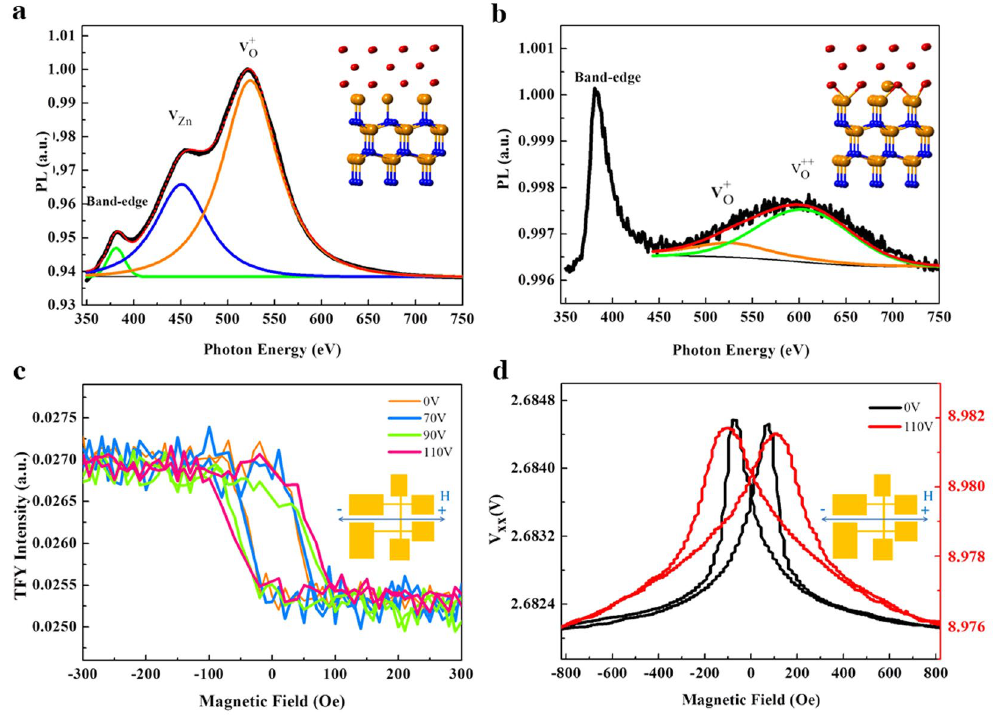
Figure 5. Magnetic properties with ex-situ treatment . PL spectra for the device ( a ) with and ( b ) without 110 V- ex-situ treatment . Inset figures of ( a ) and ( b ) illustrate the Fe-ZnO bond-broken and bond-formed situations for with and without 110 V- ex-situ treatment , respectively. ( c ) Voltage-dependent hysteresis curves of the Fe layer with ex-situ treatment . ( d ) AMR measurement of the device with (red curve, units on right y-axis) and without (black curve, units on left y-axis) 110 V- ex-situ treatment . Magnetic field direction with respect to the patterned sample is shown in inset figures.